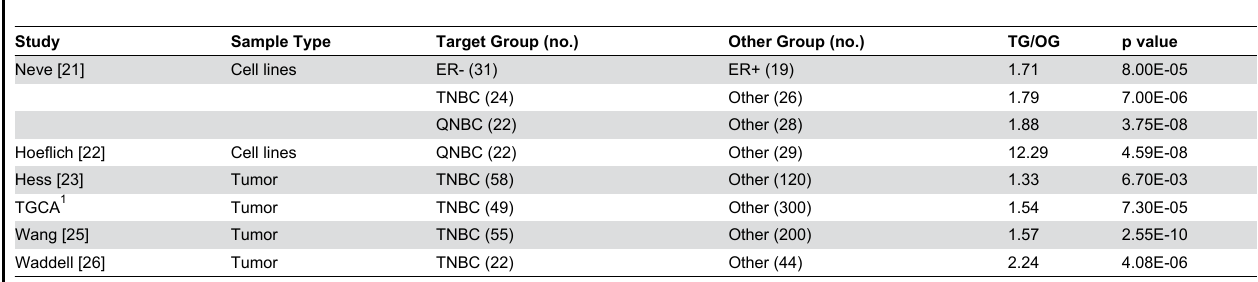
Table 1. Differential expression of ACSL4 in breast cancer as a function of receptor